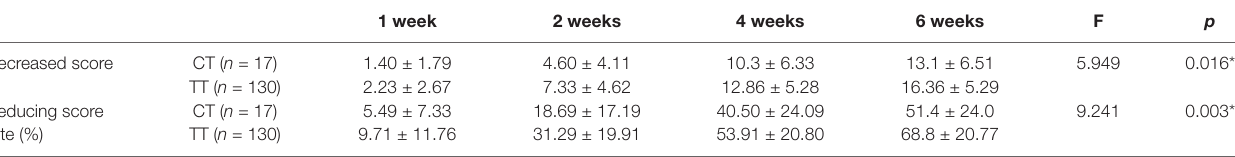
TABLE 7 | Rs2032583 and response to antidepressants.